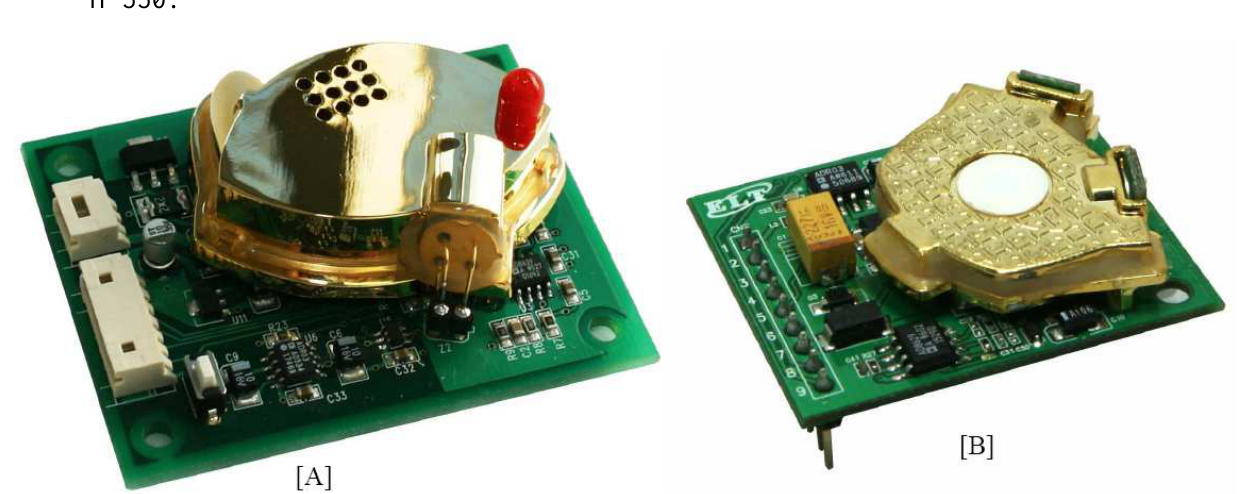
Figure 1. A picture of two different sensor types tested in this study: [A] B-530 and [B]